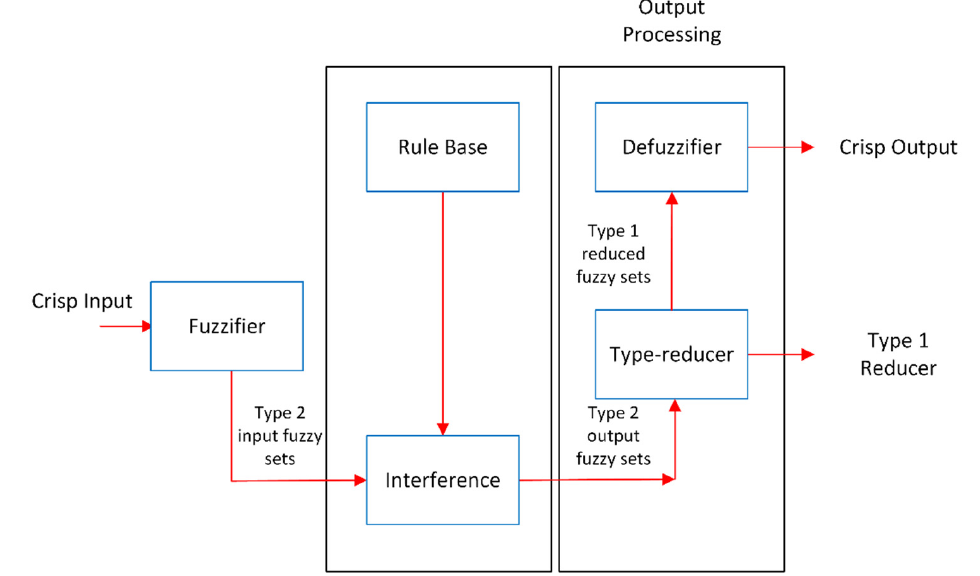
Figure 9. Fuzzy Type-2 logic system block diagram [26].